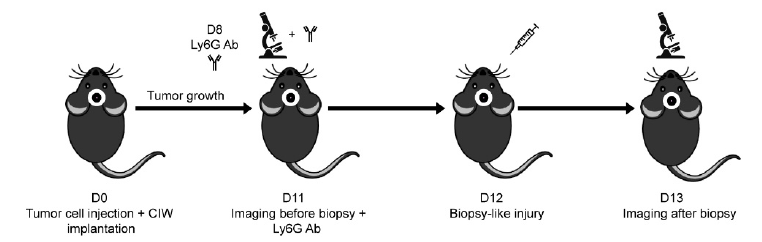
Figure 1. Cartoon showing set-up of experiment to study the effect of biopsy on in vivo glioma tumor cell migration in mice depleted of neutrophils with Ly6G antibodies.